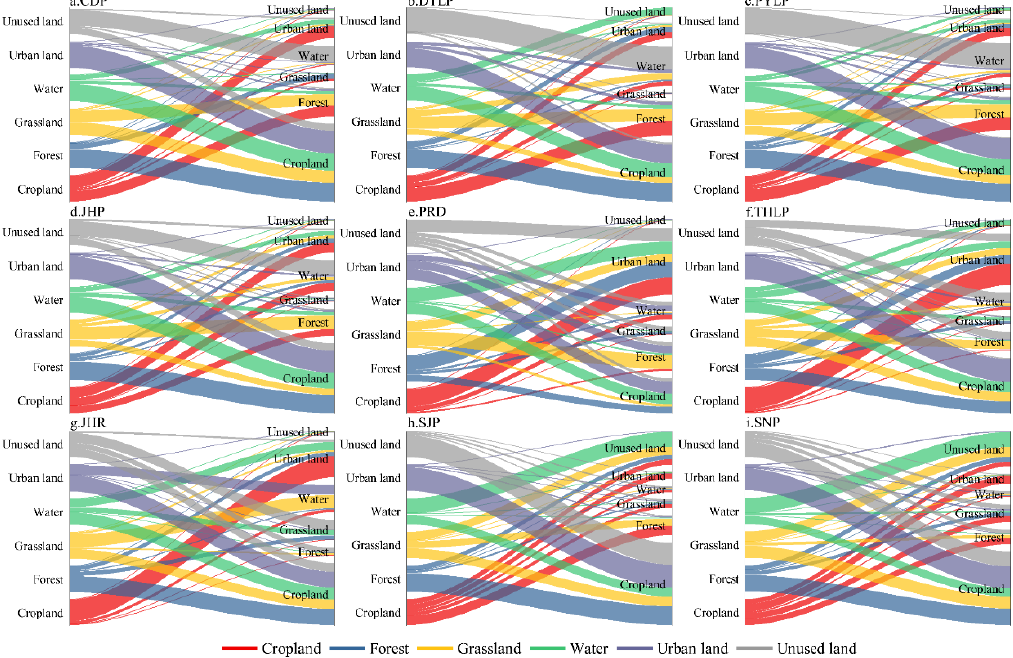
Figure 7. Land-use transfer at the individual level,